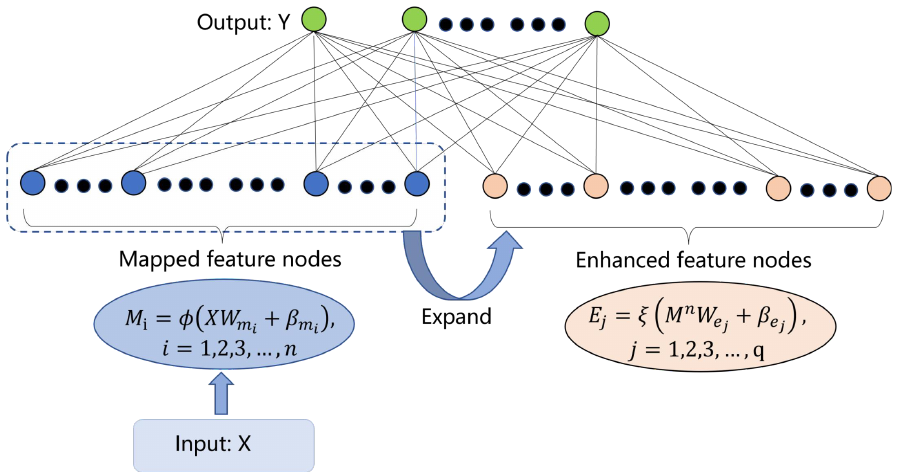
Figure 6. The structure of BLS. It encompasses mapped feature nodes and enhanced feature